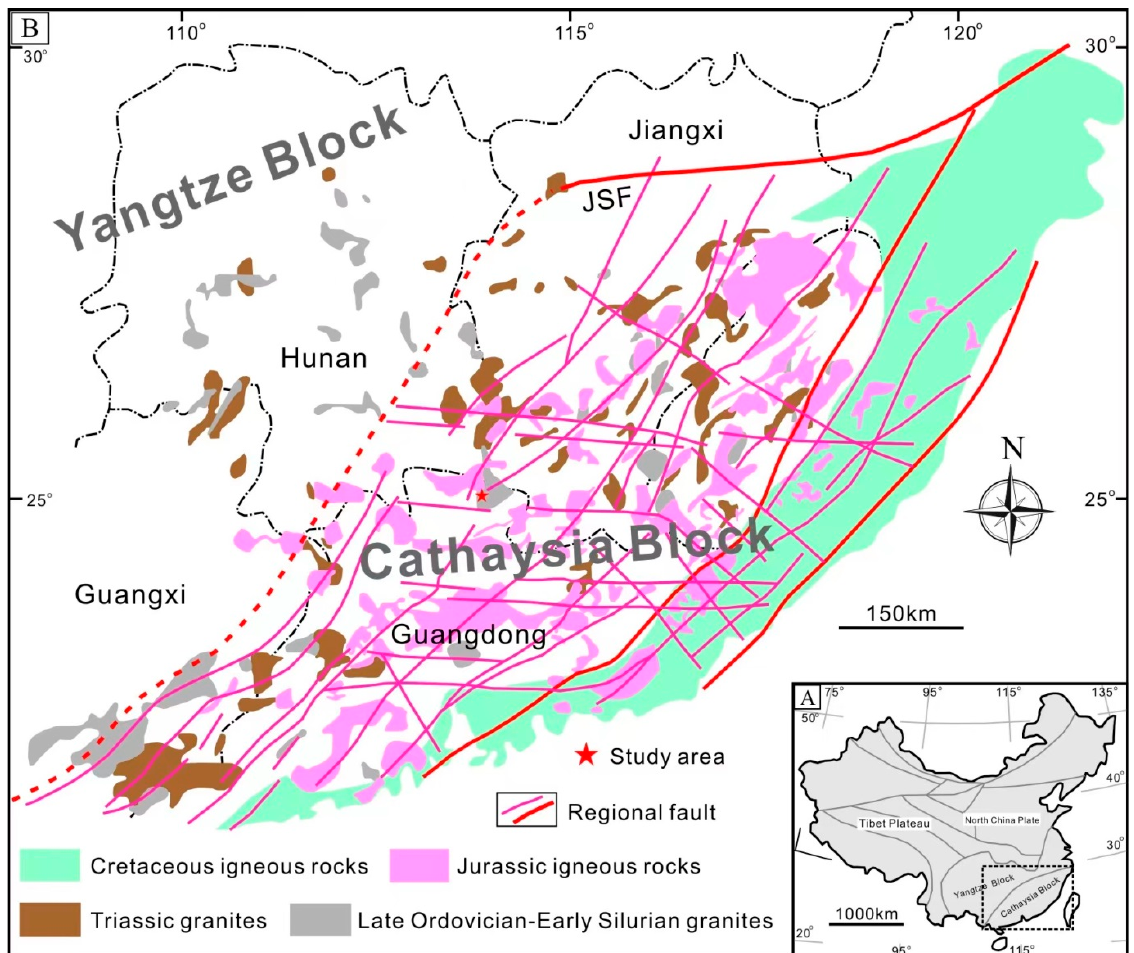
Figure 1. ( A ) Geological map showing the principal tectonic framework of China. ( B ) Schematic map of the Cathaysia block showing the structure, igneous rocks, and location of the study area (modified after Sun [10], Li et al. [11] and Lan et al. [12]. JSF: Jiangshan-Shaoxing Fault. Reprinted with permission from ref. [12].